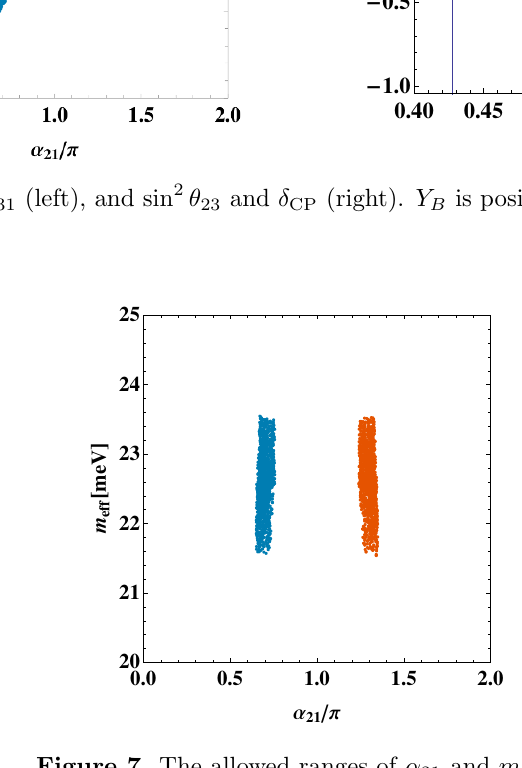
Figure 7 . The allowed ranges of (cid:11) 21 and m e(cid:11)